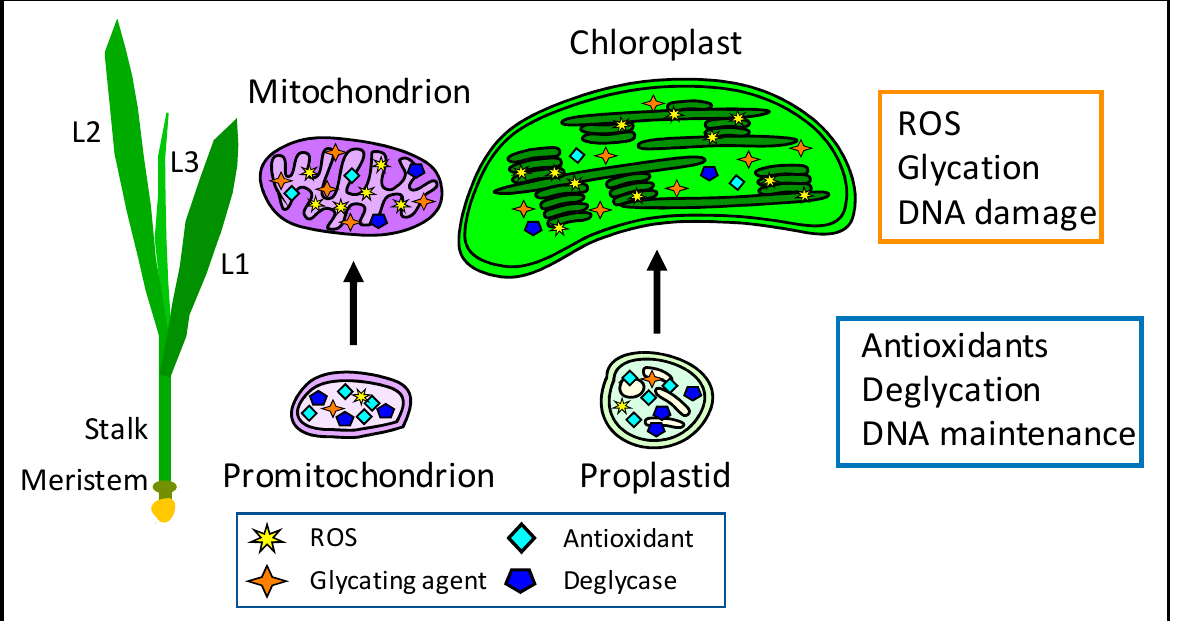
Figure 1. Damage in maize organelles during development. Cellular and organellar development in maize proceeds from the basal meristem to the fully expanded leaf blade. For light-grown maize seedlings, samples from lower 1/3 stalk (includes basal meristem), upper 2/3 stalk, and first leaf (L1) were assayed for ROS, glycation, and orgDNA damage [27,48]. Similar assays were performed for seedlings grown in light or in continuous dark using tissue from the first three leaf blades (L1, L2, and L3). Levels of antioxidants and the deglycase DJ-1 protein were higher in promitochondria and proplastids than in mature organelles. In contrast, levels of ROS and glycation products were higher in mature mitochondria and chloroplasts, where greater orgDNA damage was evident. Less ROS, glycation, and DNA damage were also found in dark-grown, etiolated leaves than in leaves grown under normal light conditions. The developmental changes from ROS and glycation damage to orgDNA result in a lower number of functional genome copies among the number typically scored as “copies” using methods such as standard qPCR [27,45,46,48]. The levels of ROS (H 2 O 2 and O 2 − ) were lower in stalk tissues than in leaves, and ROS levels increased as the seedlings developed from stalk to leaf blade [27]. Antioxidative agents were also assayed. Cellular CAT and peroxidase activities decreased, whereas small antioxidants (GSH and AsA) increased. Plastids isolated from the lower part of the stalk contained pristine DNA molecules, whereas these molecules were highly degraded in green leaves [44–46]. 8-oxoG is an indicator of oxidative damage to DNA, and the production of ROS and 8-oxoG was found to increase during maize leaf development. We